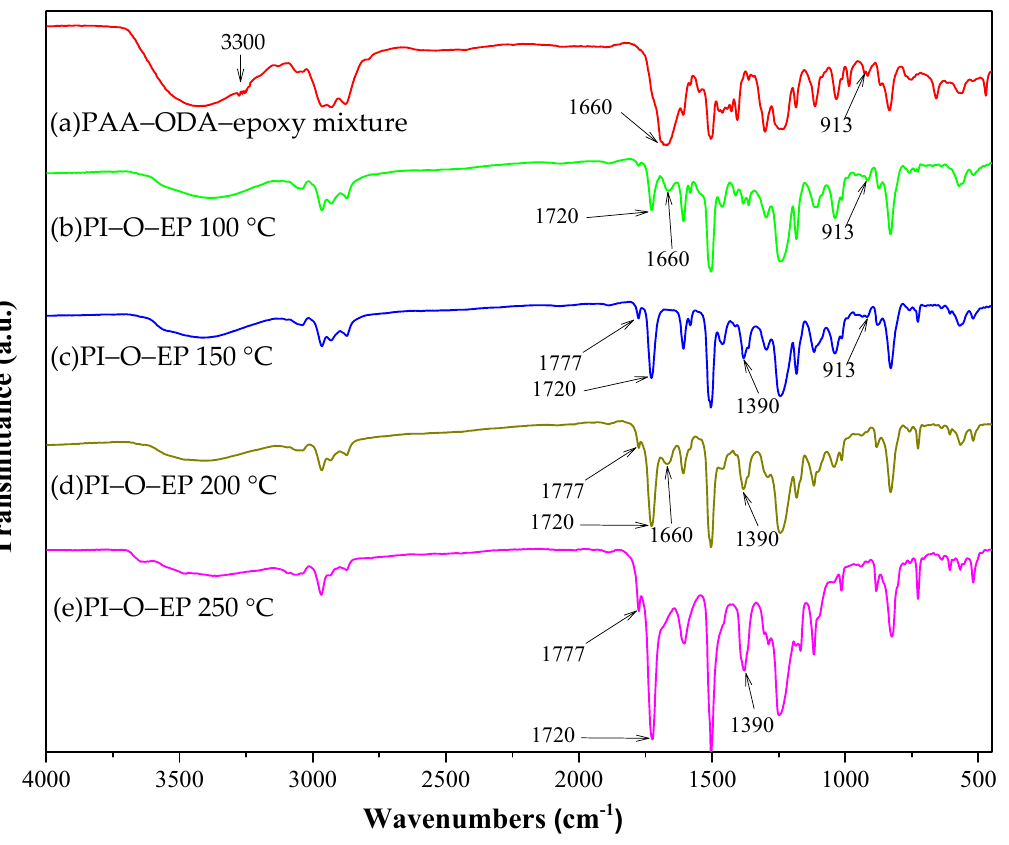
Figure 3. FTIR of the curing profile of PI(50)-O-EP(50) at different temperatures: ( a ) room temperature (unheated reaction), ( b ) 100 °C, ( c ) 150 °C, ( d ) 200 °C, and ( e ) 250 °C. In the spectra of the PAA-ODA and EP resin mixture (the reactions with EP have not yet started), 3500 cm − 1 corresponding to -OH (-COOH group of PAA) and terminal amine (3300 cm − 1 , appearing as a shoulder of the 3500 cm − 1 peak) overlap into one broad and strong absorption peak. The peak at 3300 cm − 1 disappears right after the reaction between the terminal amine and epoxide ring, which is fast at 100 °C [29]. Therefore, this overlapped shoulder at 3300 cm − 1 diminishes soon after the curing reaction between the terminal amine and the epoxide ring.